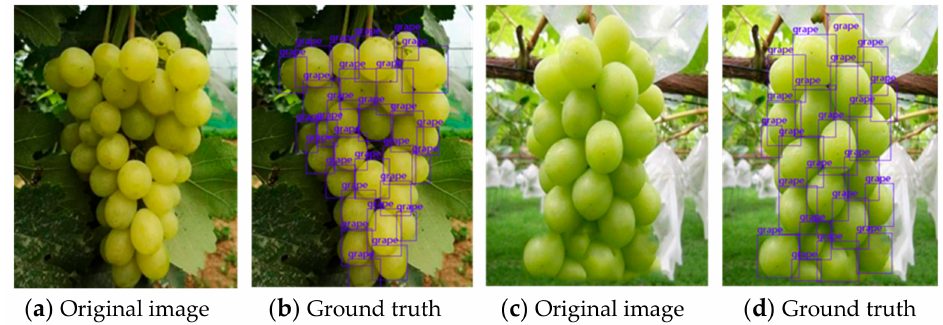
Figure 8. Grape clusters and their annotation